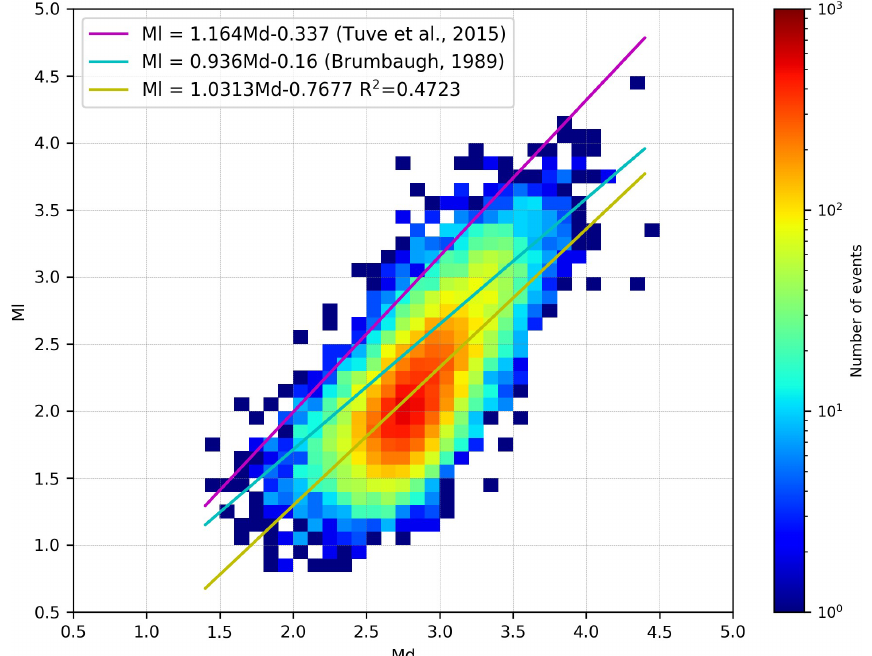
Figure 9. The relationship between M d and M l